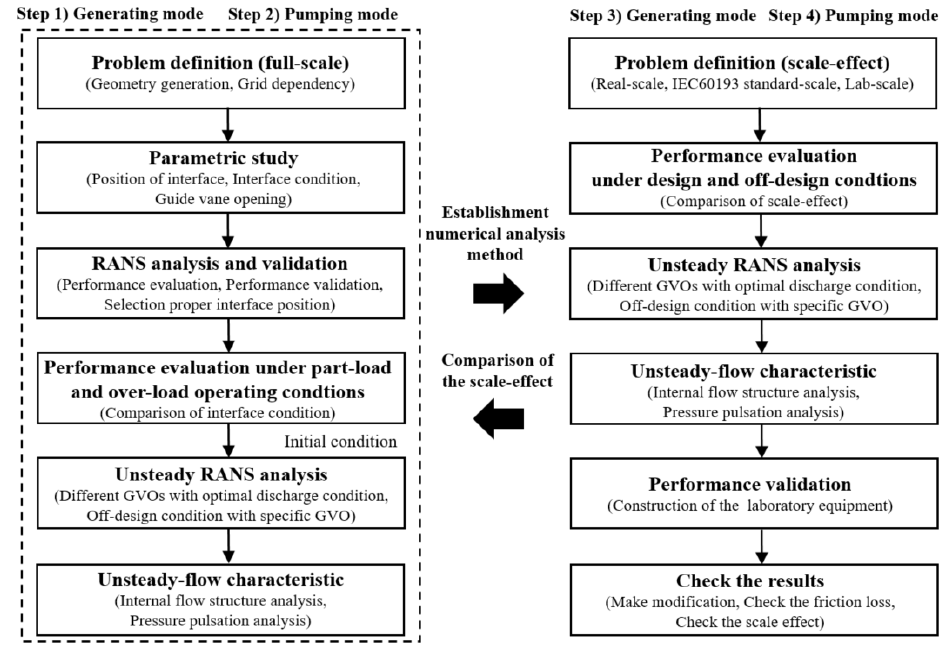
Figure 1. Establishment of the numerical analysis procedure.